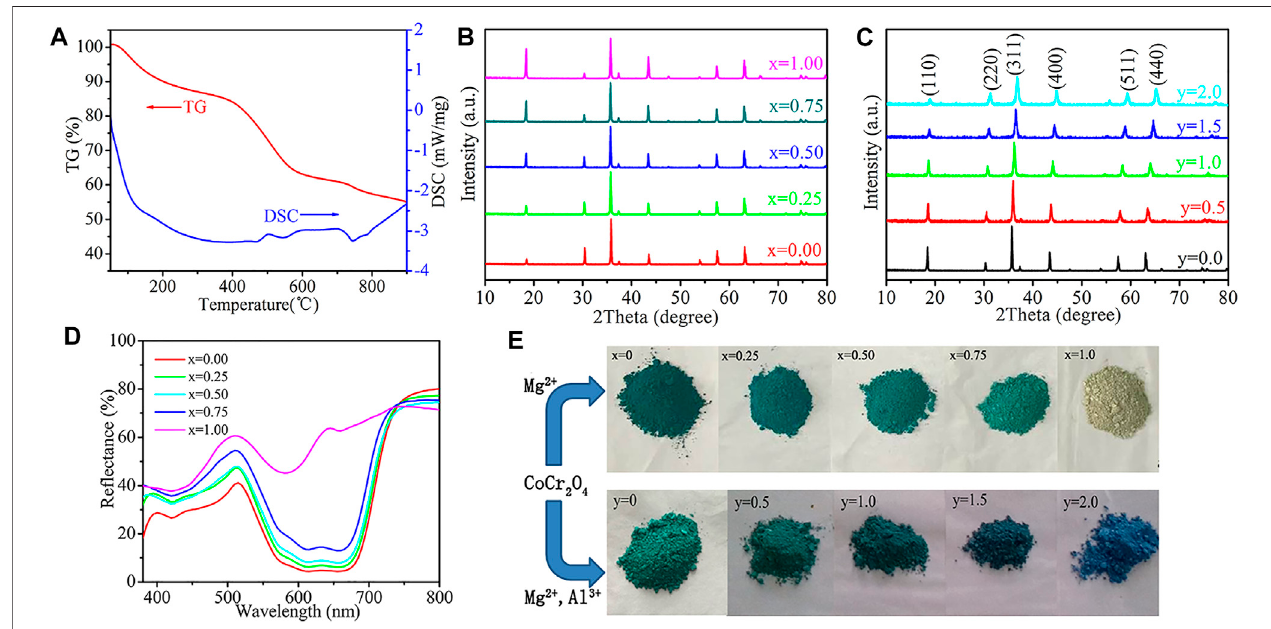
FIGURE1|(A) TG-DSCcurves ofCoCr 2 O 4 pigment precursor (B) XRDdiffraction patternsofCo 1 − x Mg x Cr 2 O 4 (x=0.00,0.25,0.50,0.75,1.00)pigments (C) XRD diffraction patterns of Co 0.25 Mg 0.75 Cr 2 − y Al y O 4 (y = 0.0, 0.5, 1.0, 1.5, 2.0) pigments (D) UV – vis absorption spectra of Co 1 − x Mg x Cr 2 O 4 (x = 0.00, 0.25, 0.50, 0.75, 1.00) powdered pigments (E) photographs of Co 1 − x Mg x Cr 2 O 4 (x = 0.00 – 1.00) and Co 0.25 Mg 0.75 Cr 2 − y Al y O 4 (y = 0.0 – 2.0)